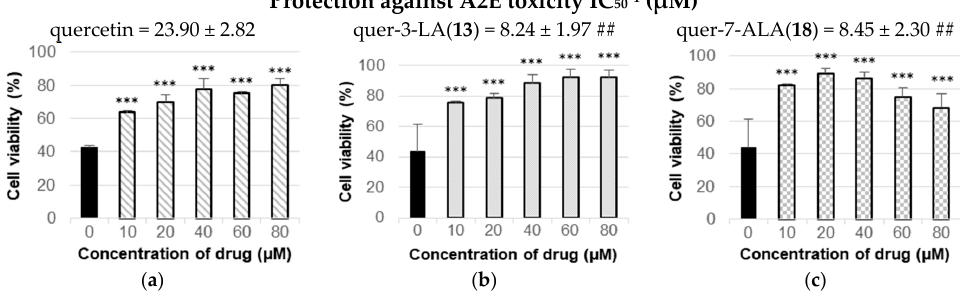
Figure 7. Protecting effect of quercetin ( a ), quer-3-LA ( b ) and quer-7-ALA ( c ) against photo-oxidized A2E, represented as cell viability (%) in function of the used drug concentration ( μ M) i.e., cells exposed to A2E and non-treated. Results are expressed in mean ± SD and are from at least n = 3 independent experiments. Results are normalized with 100% viability for non-treated and non-exposed to A2E toxicity control cells. 1 Concentration of lipophenol needed to inhibit 50% of the toxicity induced by photo-oxidized A2E. Mann-Whitney’s test, # p < 0.05, ## p < 0.01, ### p < 0.001, versus